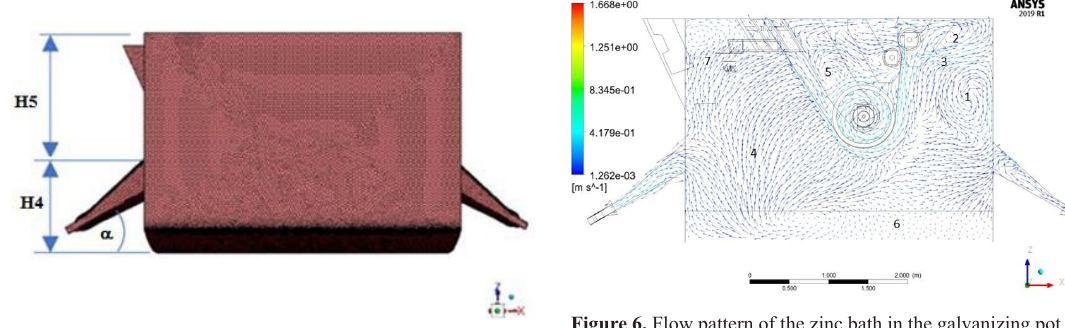
Figure 5. Side view of the pot used as a simulation model.